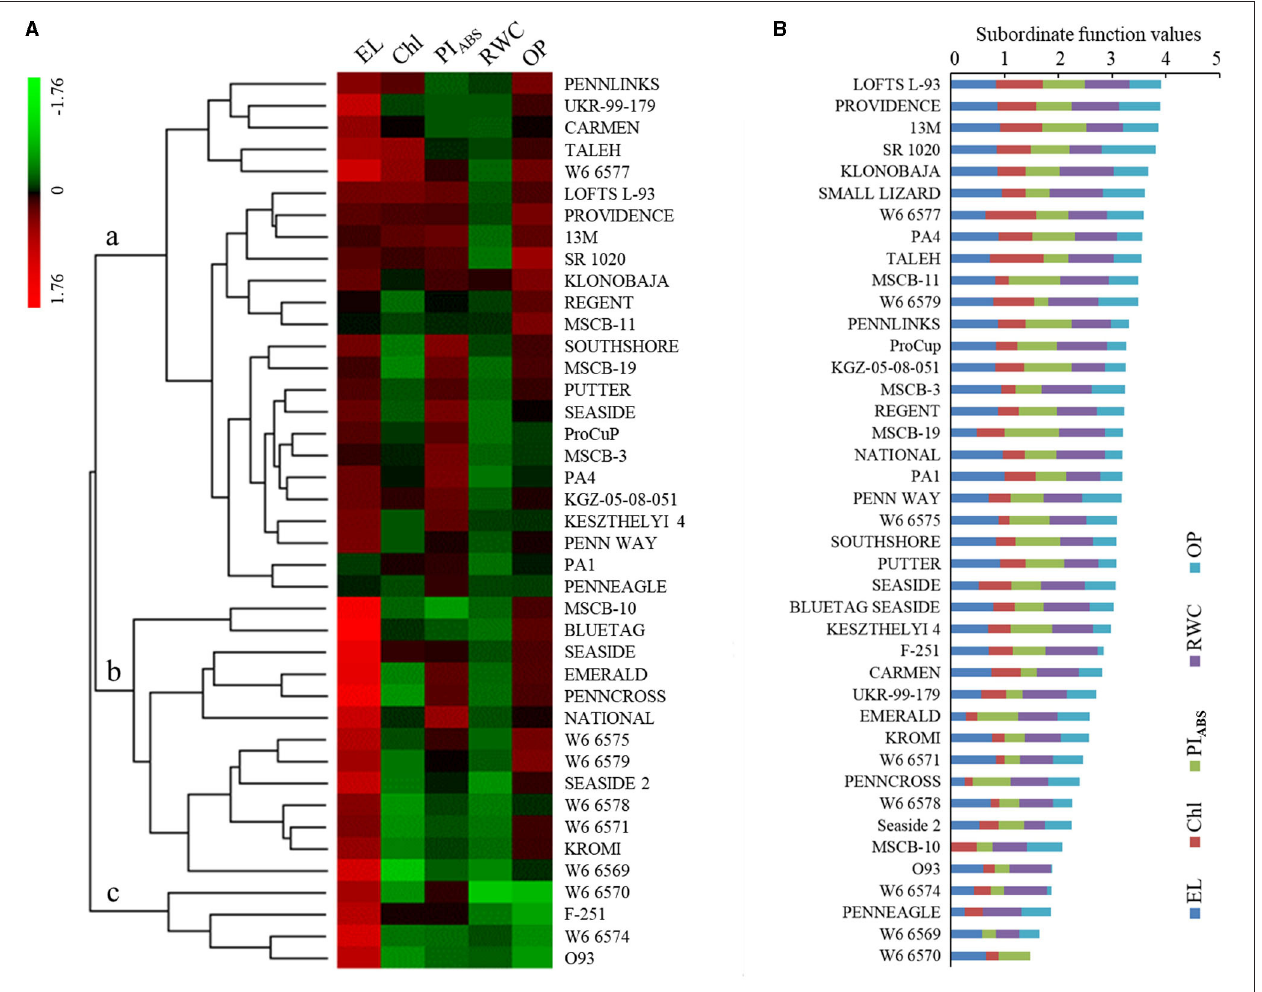
FIGURE 1 | Changes in (A) heat map that was made by log 2 FC (fold change of heat stress in relation to control under normal conditions) and (B) the subordinate function values analysis of five different physiological parameters for comprehensive evaluation of heat tolerance in 41 creeping bentgrass materials under heat stress in the controlled